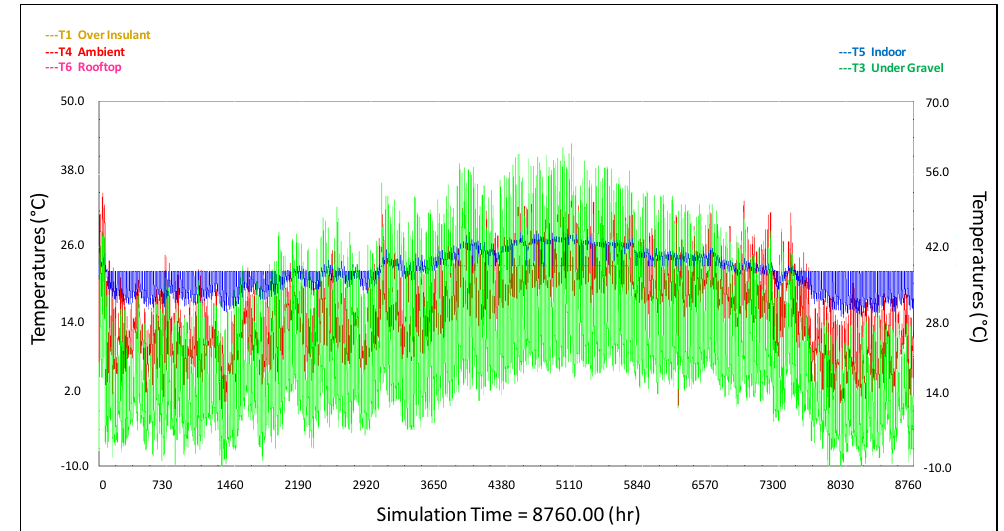
Figure 16. Results for temperatures evolution along the year.